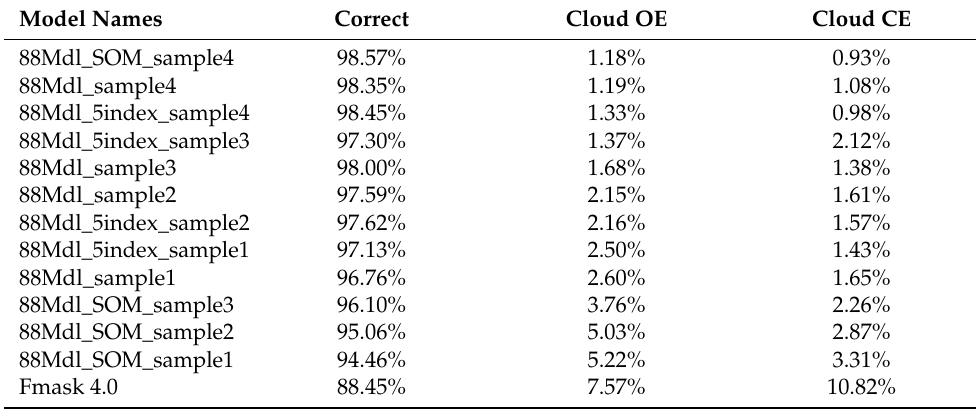
Table 5. Intra-group accuracy assessment for machine learning models and the Fmask.